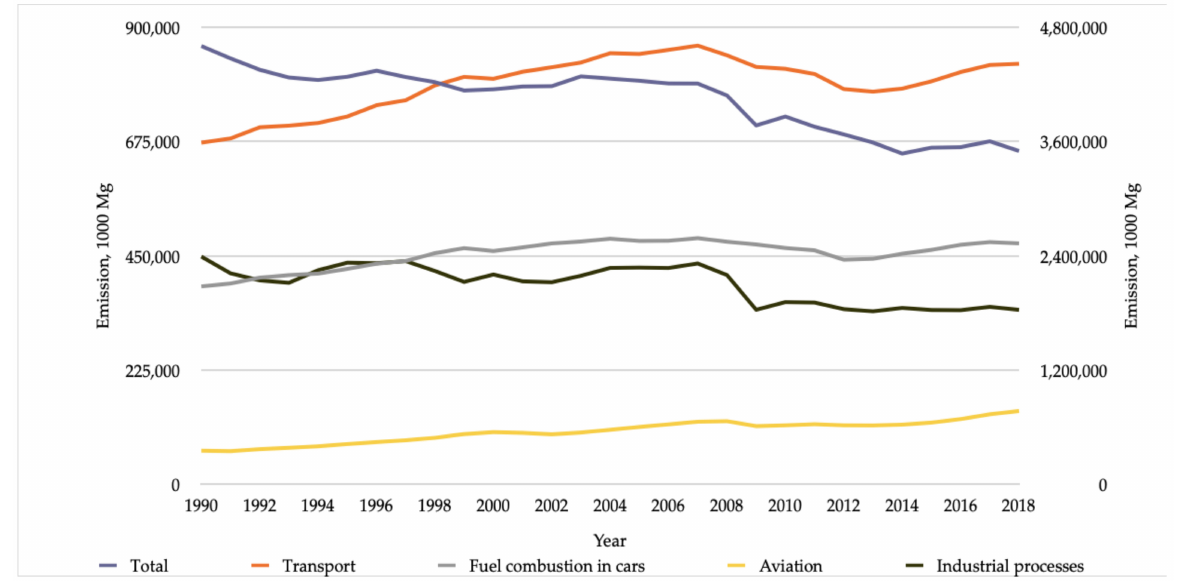
Figure 2. Gaseous air pollutant emissions in EU-27. Based on data from Eurostat, European Environment Agency (EEA)